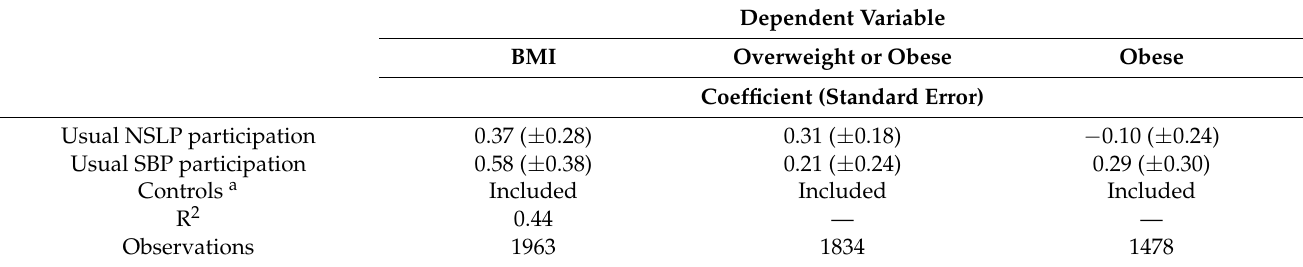
Table 4. Estimated association between usually participating in the SBP and the NSLP 3 days per week on